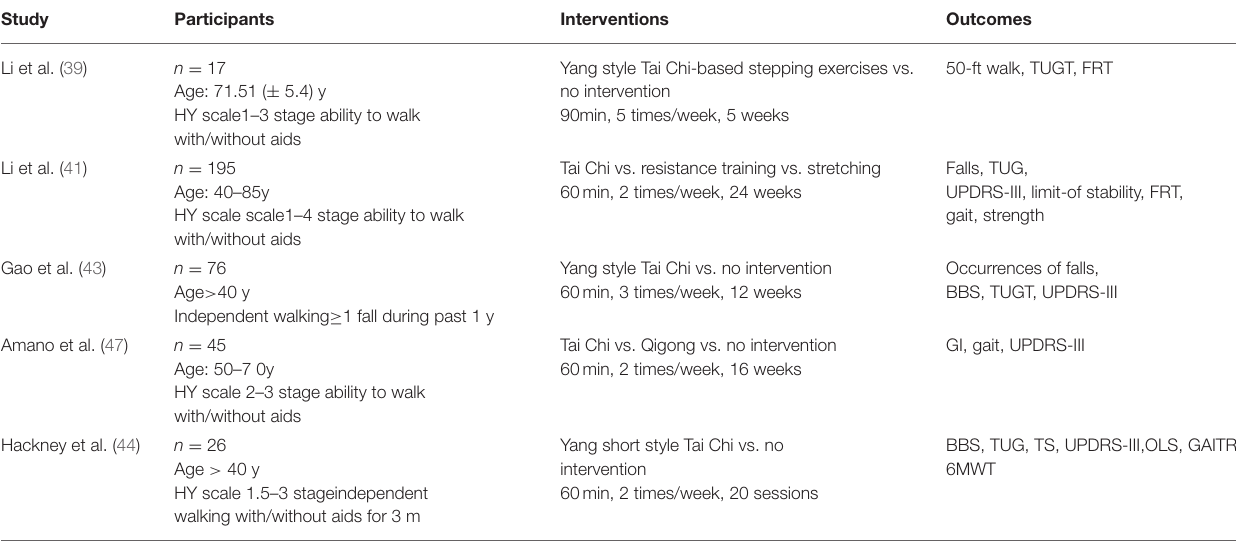
TABLE 1 | Characteristics of the included